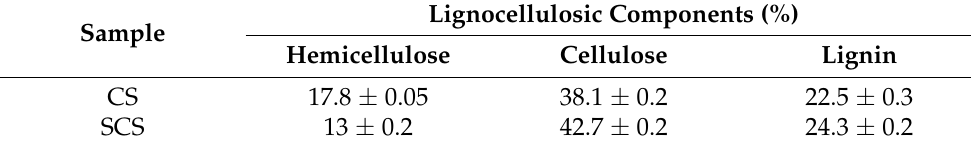
Table 1. The relative content of straw